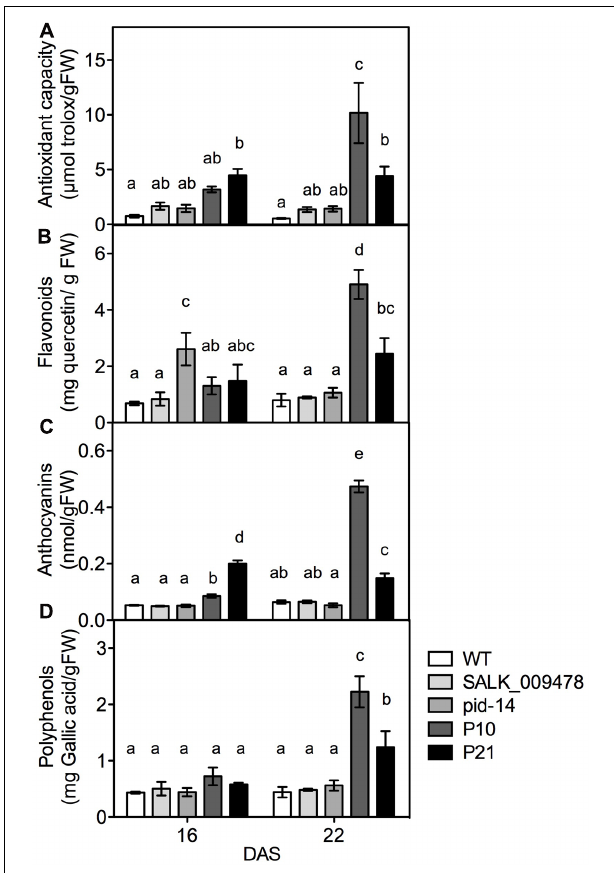
FIGURE 5 | Quantification of molecular antioxidants and related enzymes in rosettes of WT and PID overexpression lines. Total antioxidant capacity; TAC (A) , flavonoids (B) , anthocyanins (C) , and polyphenols (D) in WT and PID OE lines at 16 and 22 DAS. Different letters in the graph represent significant differences between the genotypes and time (Duncan test; P < 0.05; n = 3; Error bars: ±